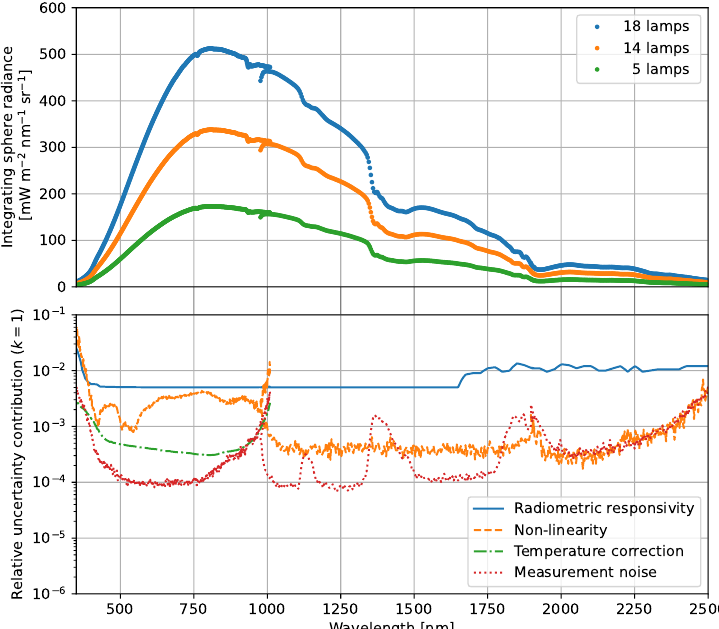
Figure 12. ( top ) Radiance from the integrating sphere at different lamp combinations as measured with the calibrated spectroradiometer. ( bottom ) Uncertainty contributions in the spectroradiome- ter